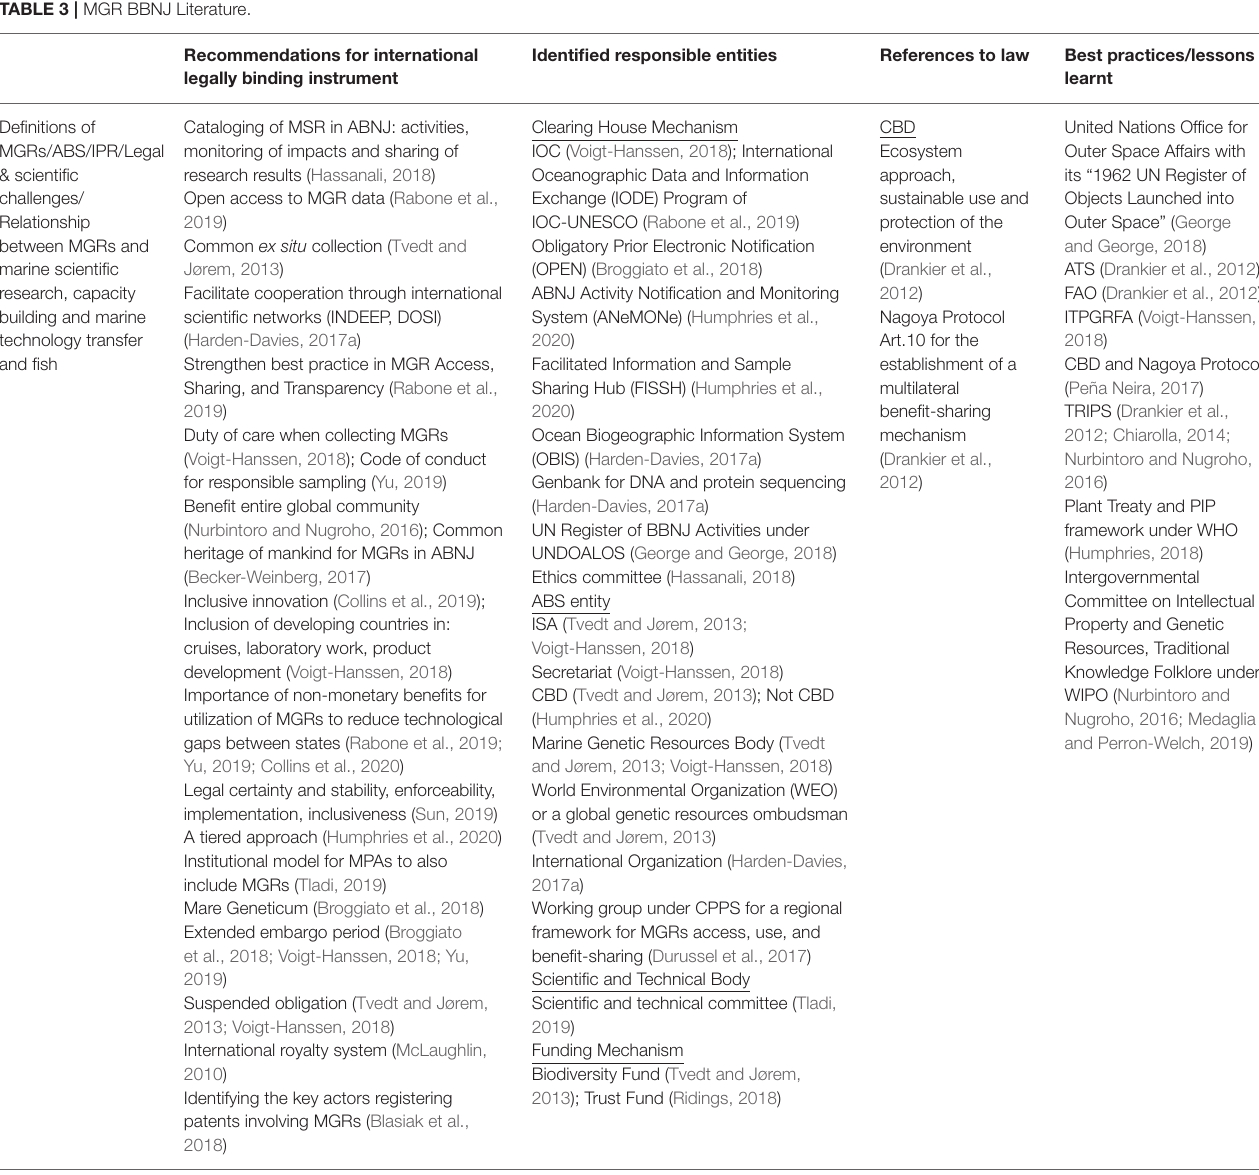
TABLE 3 | MGR BBNJ